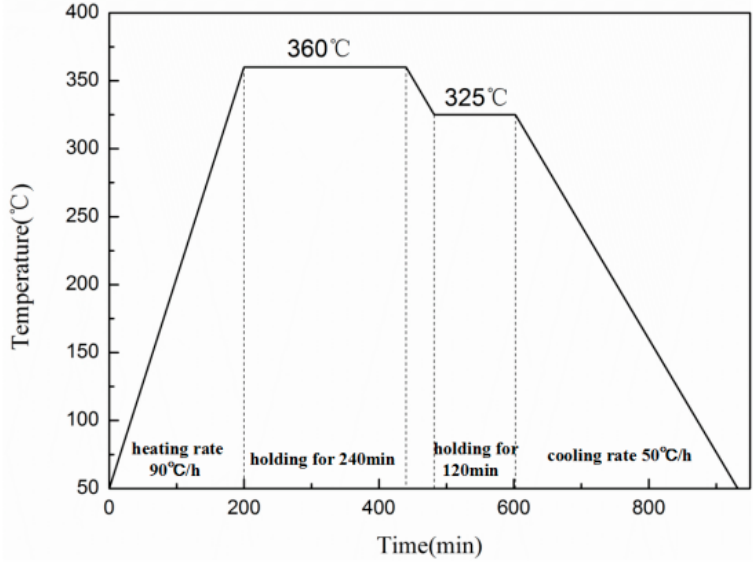
Figure 2. Sintering curve.